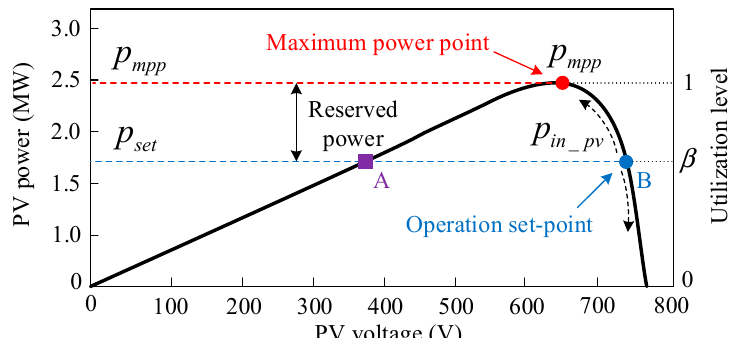
Figure 5. Power–voltage curve of the PV array with reserved power by operating the PV system at below the maximum point.